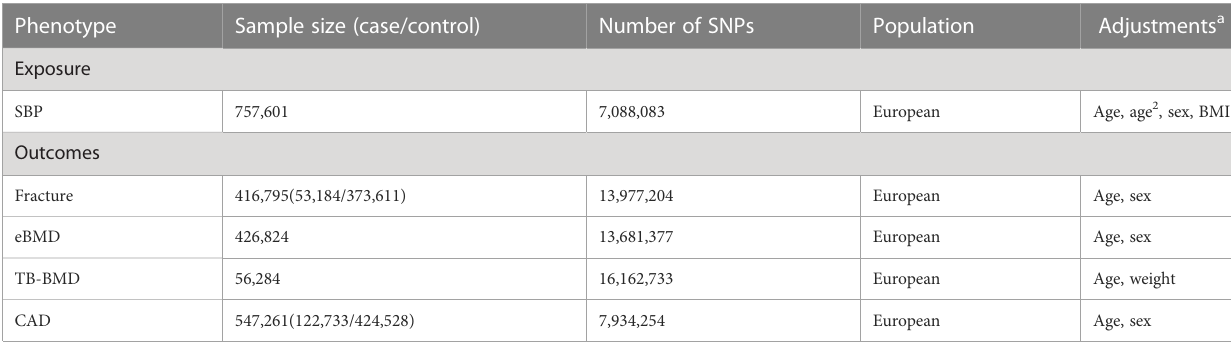
TABLE 1 Summary of GWAS datasets included in this